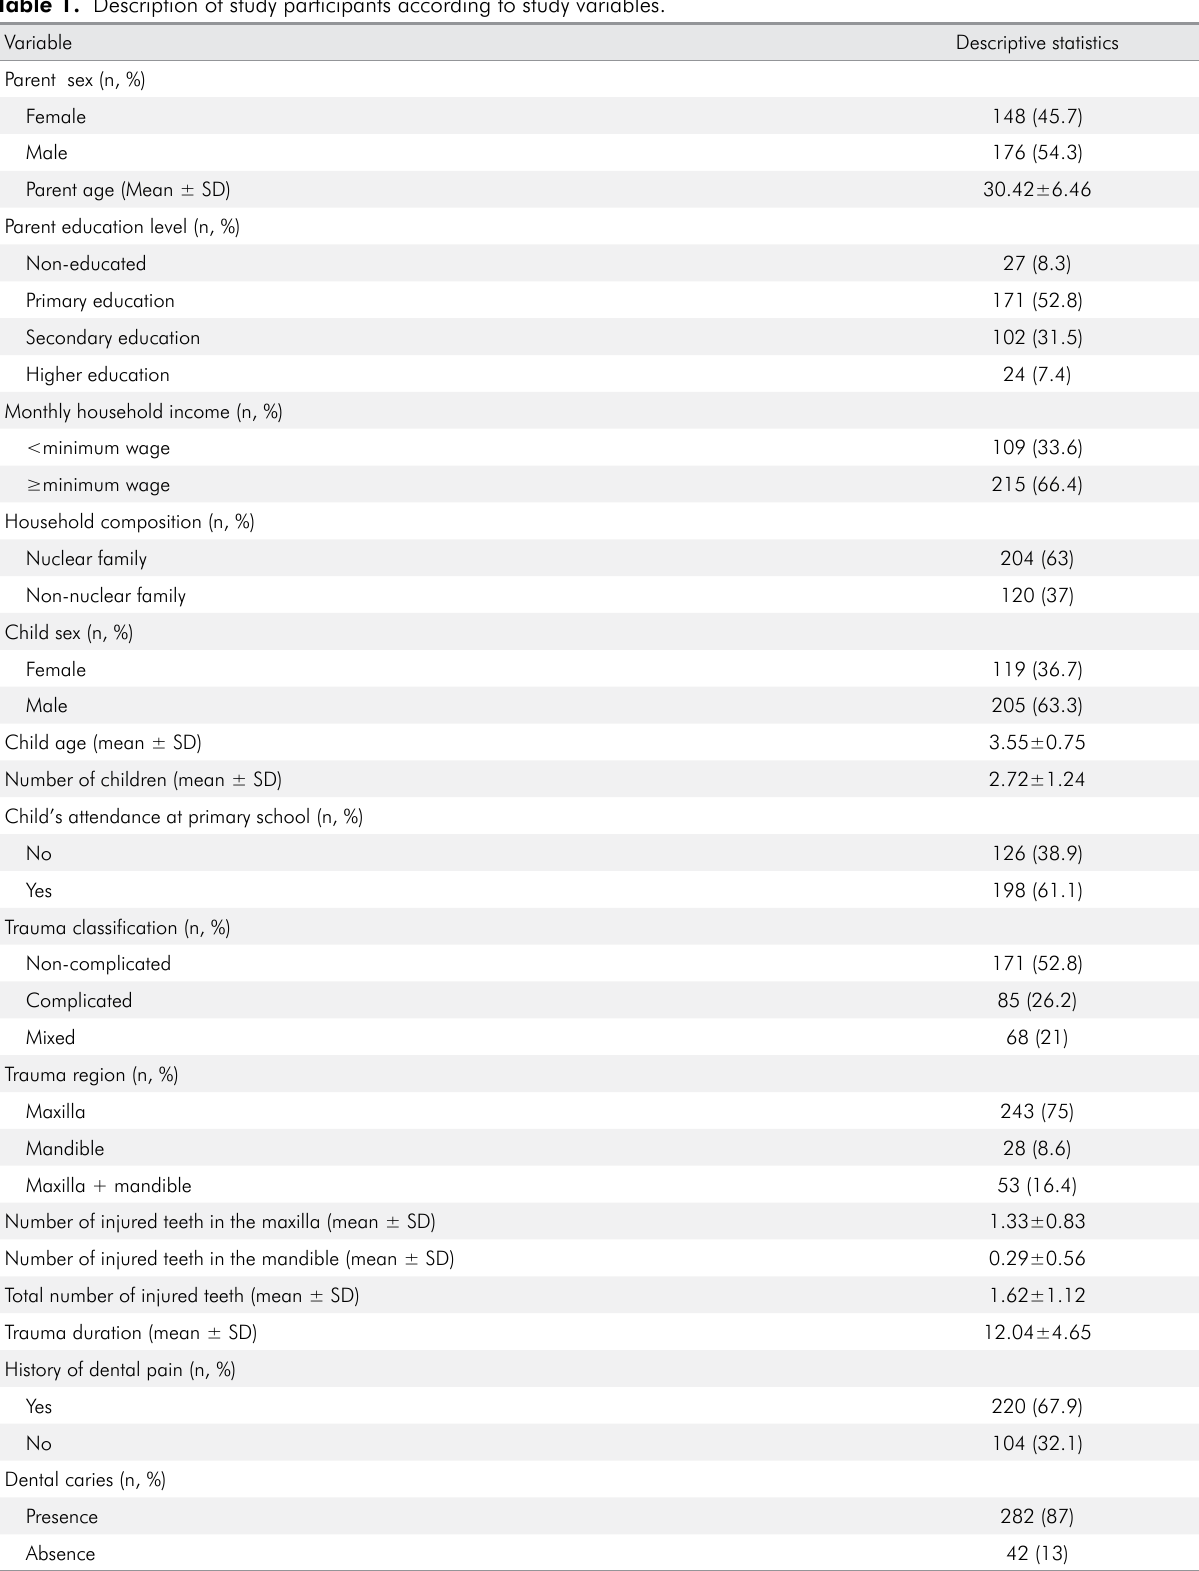
Table 1. Description of study participants according to study